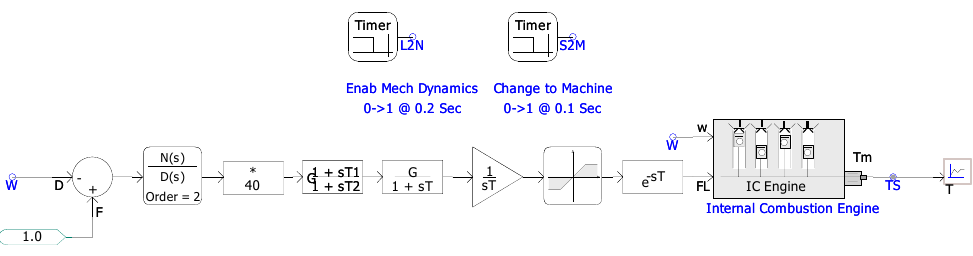
Figure 4. Diesel engine speed control system model.